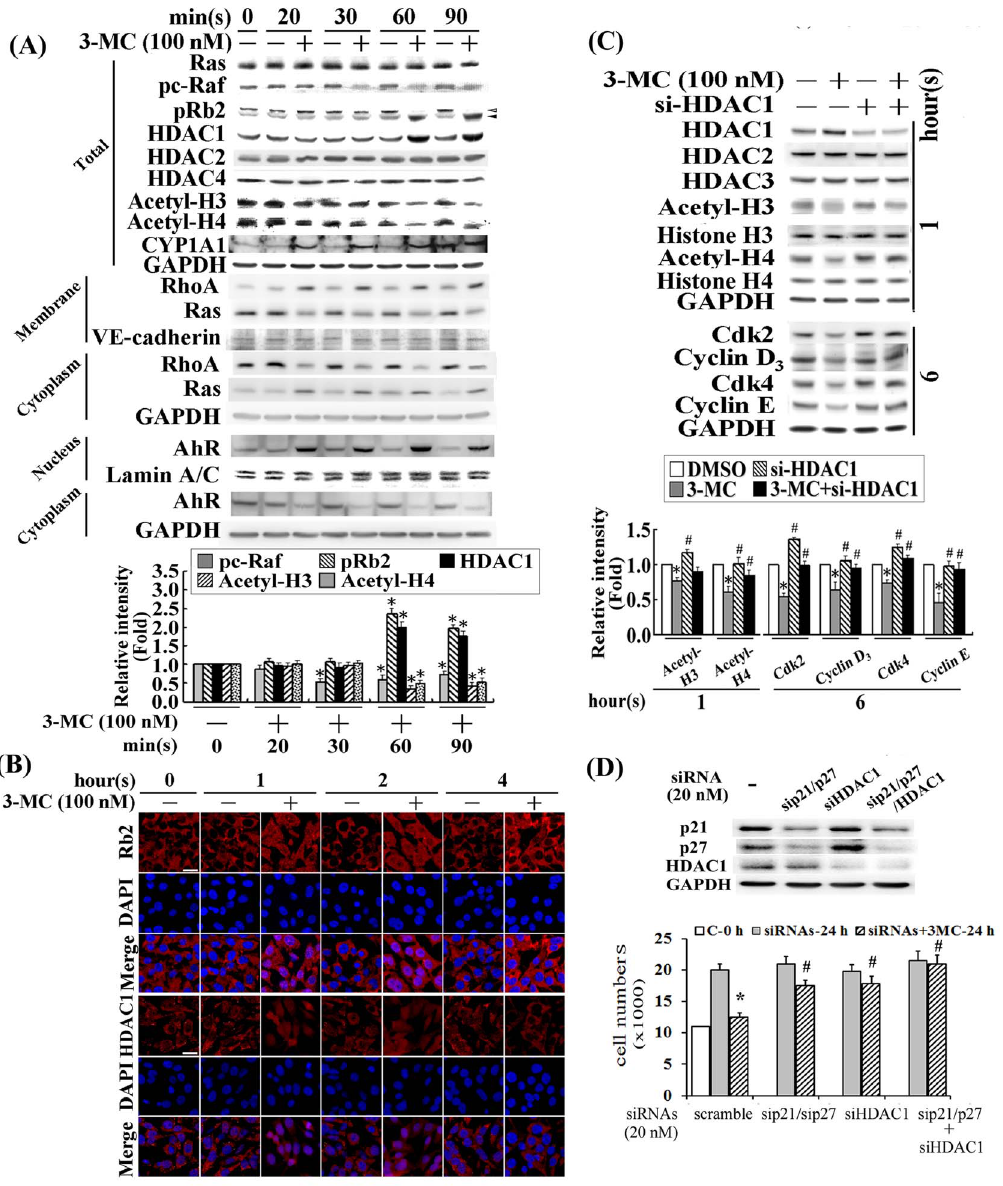
Figure 2. Effects of HDAC1/pRb2 nuclear translocation induced by 3MC in the downregulation of cell-cycle regulatory proteins by histone deacetylation. (A) Cells were harvested and fractionated from MCVECs treated with 100 nM of 3MC at the indicated times, and were analyzed using Western blot. Anti-GAPDH, anti-Lamin A/C, and anti-VE-cadherin antibodies were used to verify the equivalent loading amounts of the cytosolic, nuclear, and membrane fractions, respectively. The open and closed arrowheads represented the hyper and hypophosphorylated pRb2, respectively. (B) The effect of 3MC on RB2 and HDAC1 subcellular localization was investigated using immunofluorescent chemical staining. Cells cultured in coverslips were challenged by 3MC for 1 h; this was followed by fixation and hybridization using anti-pRb2 and anti-HDAC1 antibodies and then a second antibody conjugated with Texas Red. In Figure 2B, red represents pRb2 or HDAC1-positive staining in the cytosol or nuclei. The identical fields were also stained using DAPI to target the nuclear position. We used 630 6 magnification (scale bar in white =50 m m) and recorded micrographs of the representative fields. (C) Cells were transfected with siHDAC1 (20 nM) overnight, prior to treatment with 3MC for 1 or 6 h. The protein levels of acetylated H3/H4, Cdk2/4, and Cyclin D3/E were assayed using Western blot. Membranes were probed using an anti-GAPDH antibody to verify equivalent loading. Three samples were analyzed in each group, and the values reported represent mean 6 SEM (* P , 0.05 vs. control group; # P , 0.05 vs. 3MC treatment alone). (D) Cell numbers were counted for cells with indicated siRNA transfection followed by a 24 h of the 3MC challenge by using a hemo-cytometer. Data are presented as mean 6 SEM of 3 independent experiments (* P , 0.05 vs. control or siRNA group; # P , 0.05 vs. 3MC treatment alone). and HDAC1 (Figure 2B) to interact with each other or participate increased the interaction between pRb2 and HDAC1, but also in the E2F1 complex formation. The Co-IP results from using an enhanced the AhR recruitment to this complex. In addition, a Co- IP assay using an anti-E2F1 antibody (Figure 5A) showed that anti-pRb2 antibody showed that the 3MC challenge not only